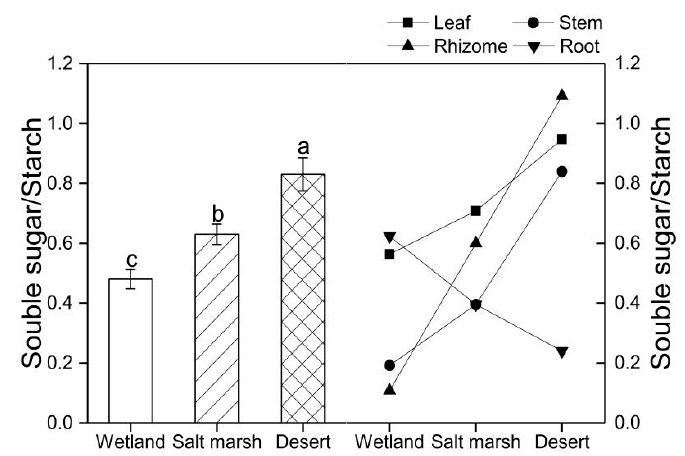
Figure 4. Comparison of soluble sugar and starch ratios of Phragmites communis in different habitats (Histograms represent the soluble sugar to starch ratio of the whole plant, and the alphabets indicate significance among different habitats at p < 0.05 level. Error bars represent standard deviation).